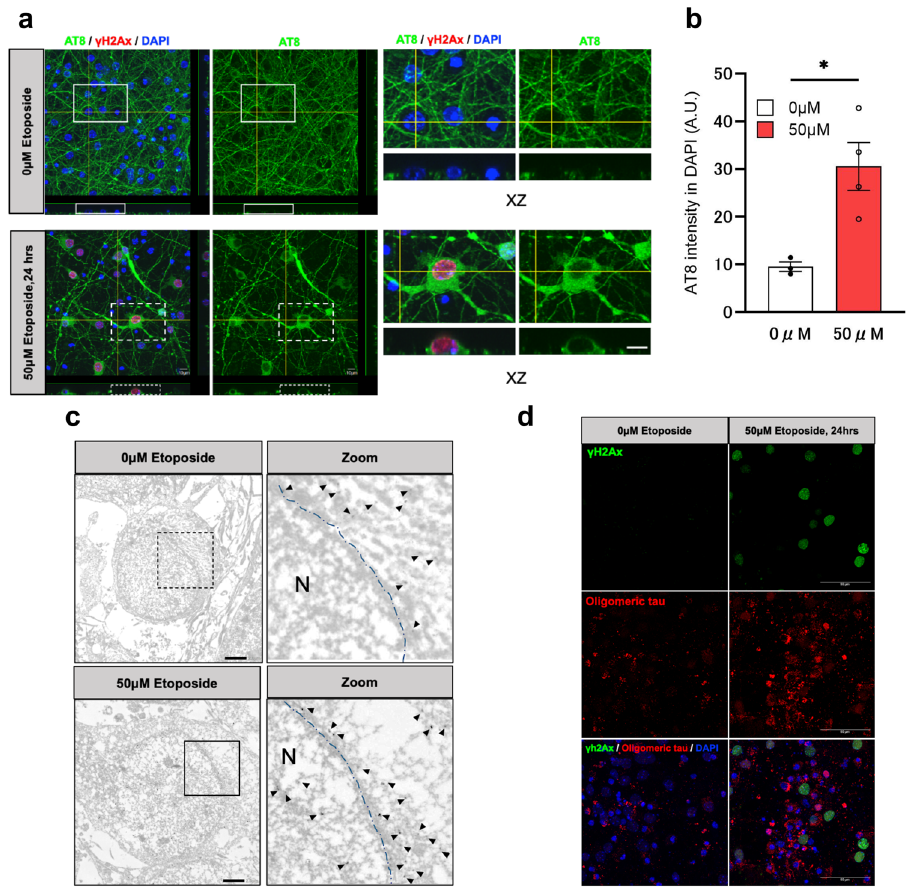
Fig. 4 Accumulation of p-tau and toxic tau around the nuclear membrane of neurons by DSB induction. a Left panels: representative XY, YZ, and XZ projections of immuno fl uorescent staining using antibodies against p-tau (AT8, green) and γ H2Ax (red) and DAPI (Blue) with non-treatment (0 μ M etoposide) and 50 μ M etoposide treatment for 24 h (50 μ M Etoposide, 24 h). Right panels show magni fi ed XZ projections of white solid dotted squares in the left panels. Scale bar = 10 μ m. b Quanti fi cation of the AT8 intensity in DAPI area. White column is non-treatment ( n = 3), red column ( n = 4) is 50 μ M etoposide treatment for 24 h. n : number of images examined; * p = 0.0168, The p -value was obtained by Student ’ s t test. c Immunogold electron micrographs from primary mouse cortical neurons with non-treatment (0 μ M etoposide) and 50 μ M etoposide treatment for 24 h (50 μ M etoposide, 24 h.), showing AT8 positive p-tau around the nuclear membrane (AT8). Zoom panels show enlarged projections of dotted square and solid square. Arrowheads indicate gold particles for AT8 antibody. N nucleus; Blue dash line, nuclear membrane. Scale bar = 2 μ m. d Immuno fl uorescence using antibodies against oligomeric tau (T22, red) and γ H2Ax (green) with DMSO treatment (left panel) and 50 μ M etoposide treatment for 24 h (right panel). Scale bar = 30 μ